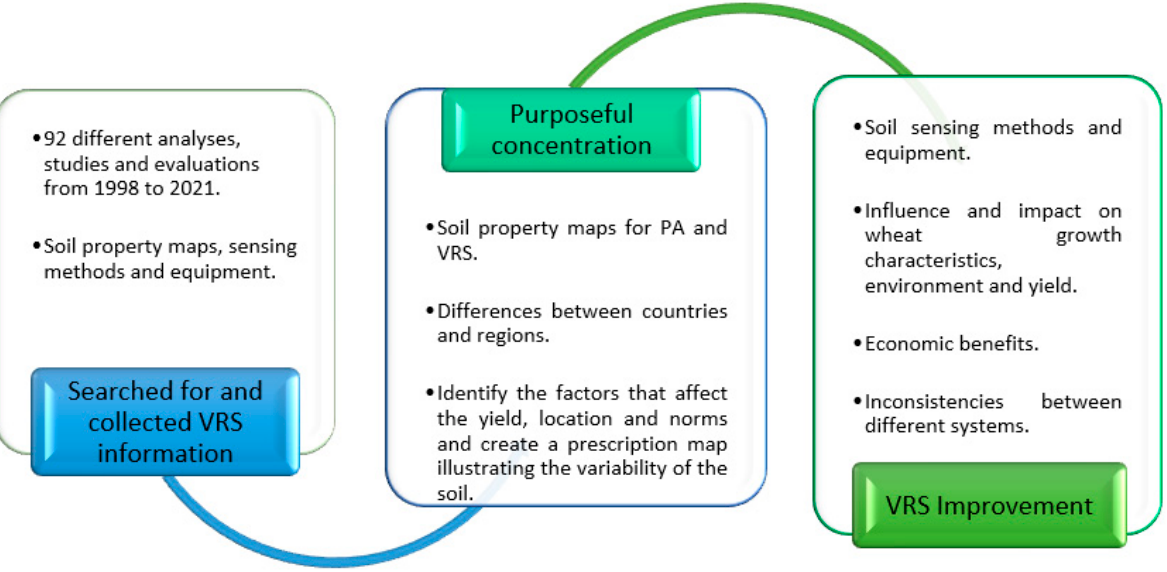
Figure 3. Method of evaluation of variable rate seeding methods and their applications in practice.